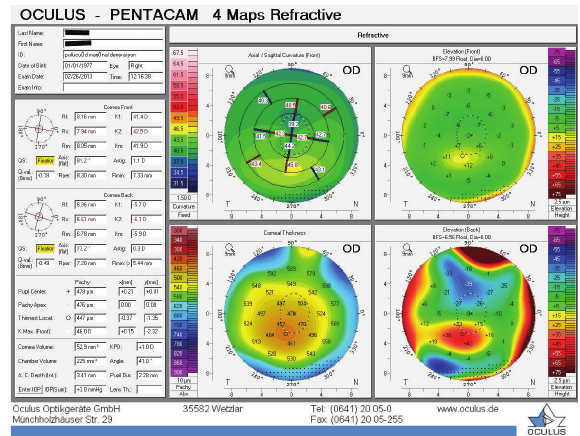
Figure 7: Patient 2, right eye at the last